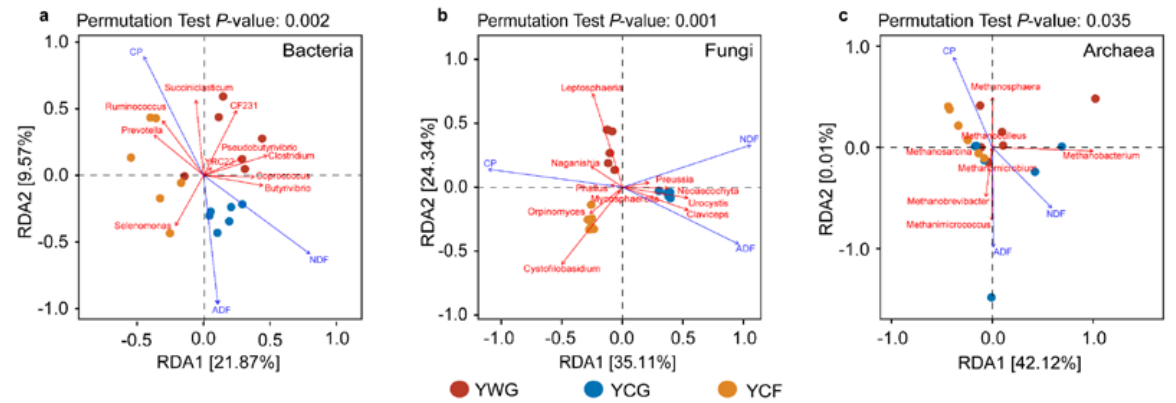
Figure 4. Correlation analysis of the rumen microbial communities with dietary nutrition characteristics. Redundancy analysis (RDA) plot showing the correlations between fermentation characteristics and rumen bacteria ( a ), fungi ( b ), and archaea ( c ) community composition. The canonical axes are labelled with the percentage of total variance explained (%). Arrow lengths indicate the variance explained by dietary nutrition characteristics. Individual yaks from different experimental groups are presented as separate data points. YWG: Warm-season grazing, YCG: Cold-season grazing, YCF: Cold-season indoor feeding.